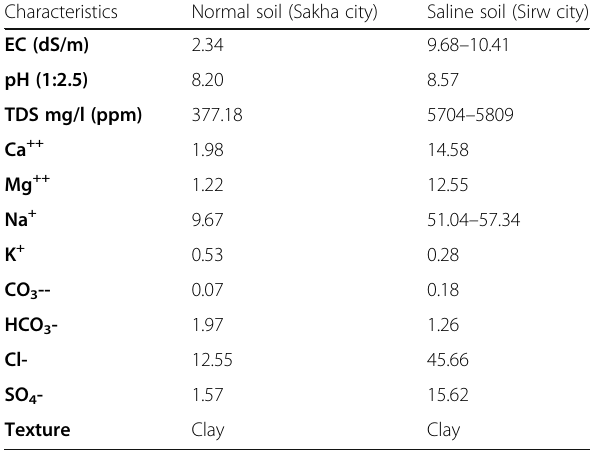
Table 1 Chemical classification of normal and salinity soils